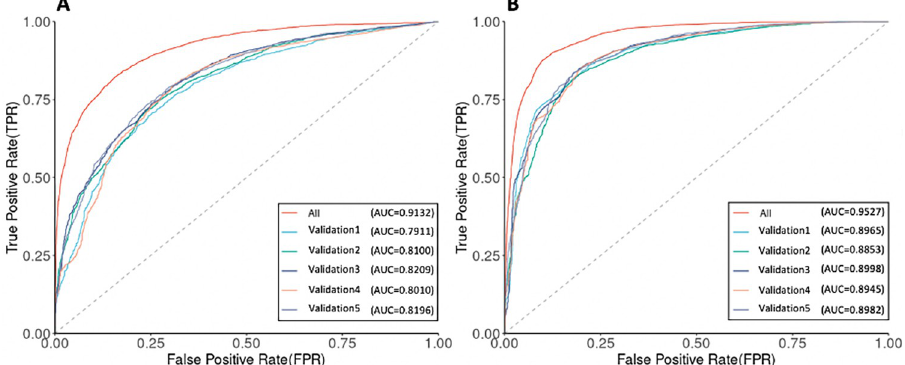
Fig 1. ROC curves and AUC values of the P . falciparum complete dataset and five validation-datasets. (A) The mononucleotide STR model. (B) The polynucleotide STR